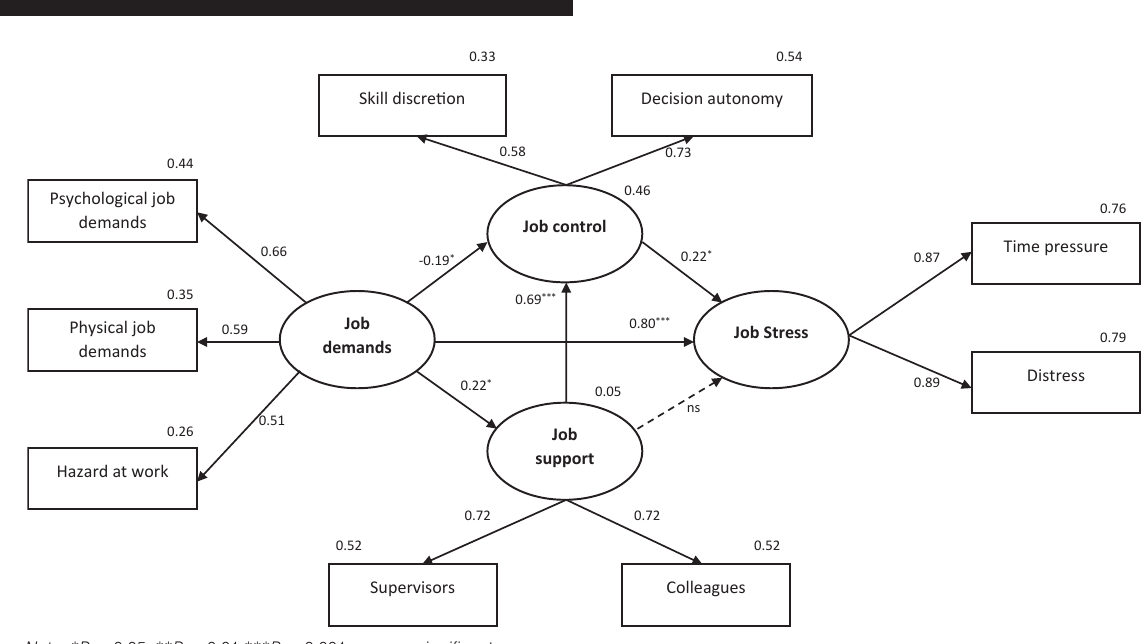
Figure 3. The modified model of job stress among Thai nurse-midwives.